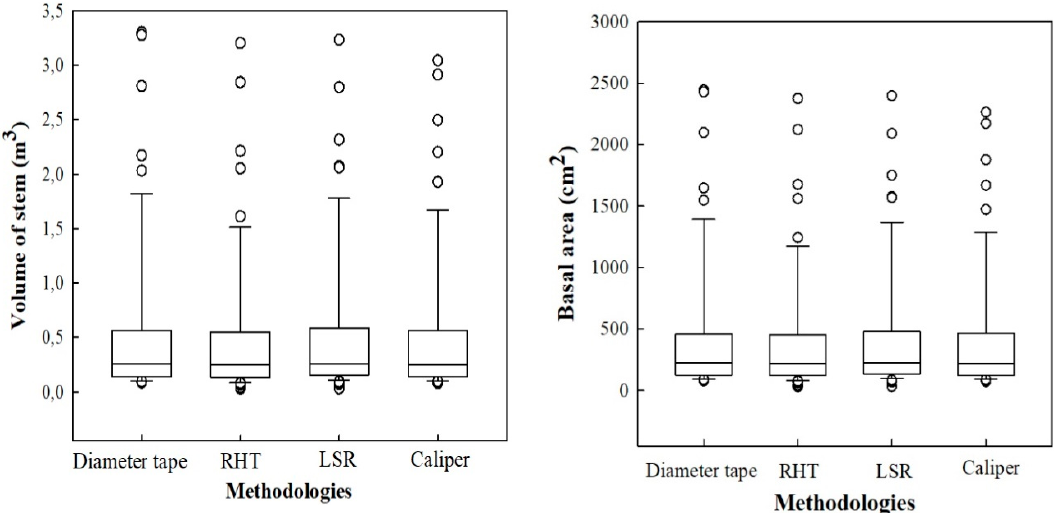
Figure A1. The volume of the stem (V stem ) using the formula (ln V = − 7.335 + 2.121 ln DBH) proposed by Higuchi et al. (1997) and the basal area for the respective methodologies, i.e., diameter tape (Diameter tape), TLS RHT (RHT), TLS LSR (LSR), and electronic caliper (Caliper), used to estimate the plot-level parameters for trees (DBH ≥ 10 cm).